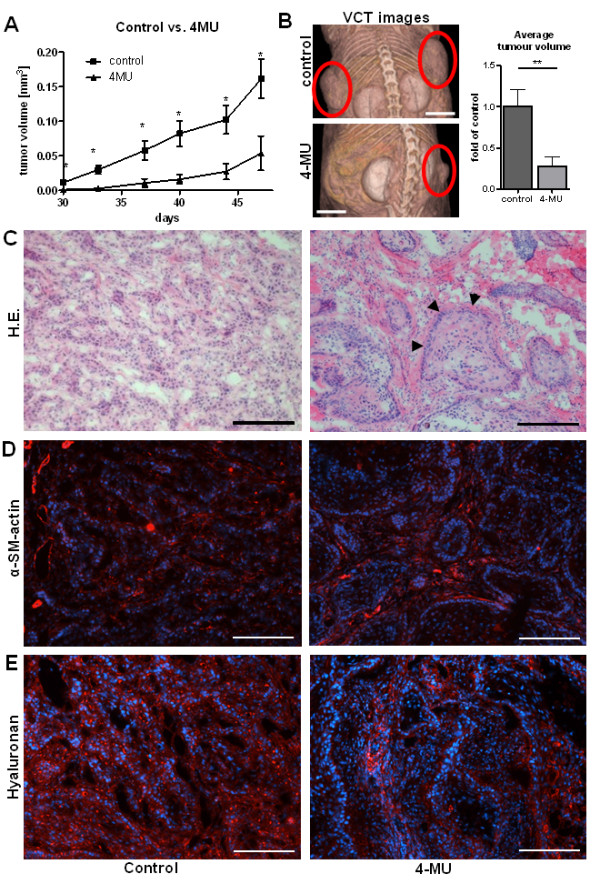
4-MU treatment inhibited tumour growth of OSC1 cells in nude mice. Nude mice received subcutaneous injection of 106 OSC1 cells, and tumour growth was monitored for 47 consecutive days. (A) Tumour volume as determined by calliper measurements; mean ± SEM, n = 21 (control), 17 (4MU); *, p < 0.05. (B) Representative fpVCT images of control mice and 4-MU treated mice. Scale bars, 1 cm. Average tumour volumes after sacrification of mice at the end of the experiment as measured by fpVCT showed a significant reduction in tumour volume in the 4-MU group. (C) Cryosections stained with H&E demonstrated a differentiated tumour phenotype in mice treated with 4-MU. This phenotype was characterised by larger tumour cell clusters with a cell-rich border region (arrows) and pronounced tumour stroma. Scale bars, 200 μm. (D) Stromal fibroblasts were stained with alpha-smooth muscle actin staining (red). Scale bars, 200 μm. (E) Hyaluronan staining (red) was associated with both tumour cells and stromal tissue and was markedly reduced by treatment with 4-MU. Scale bars, 200 μm. Shown are representative images of n = 6 (control) and n = 7 (shHAS3) experiments.